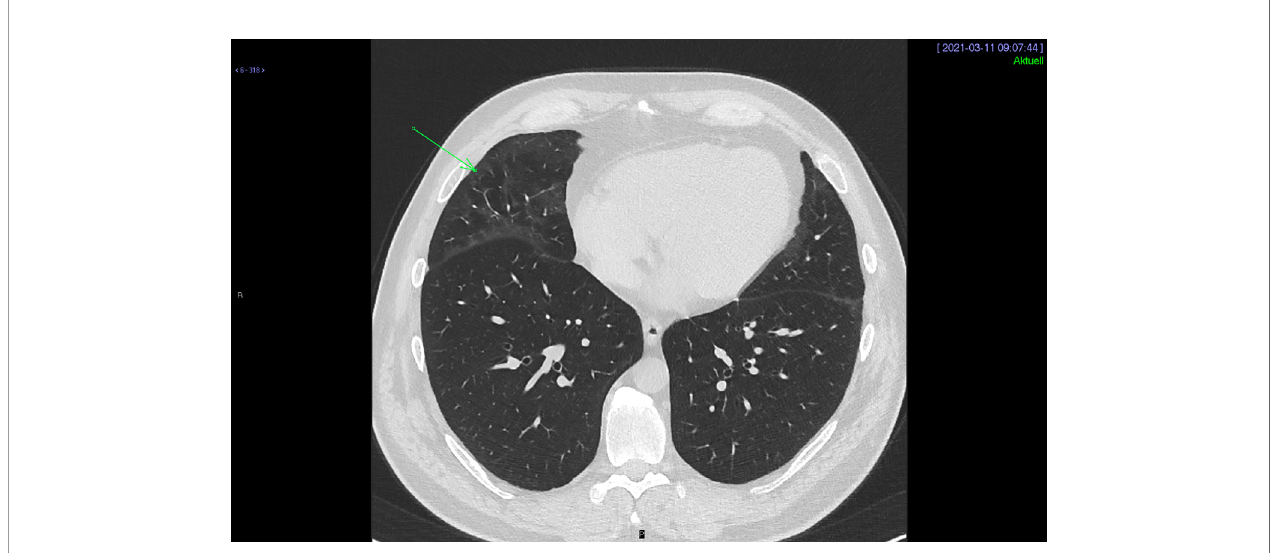
FIGURE 2 | Peripheral subpleural ground-glass opacities compatible with early stage of interstitial lung disease (arrow) are present in the anterior and basal segments of the right middle lobe as well as along the oblique (major) fi ssure, and on the left side within the lingular